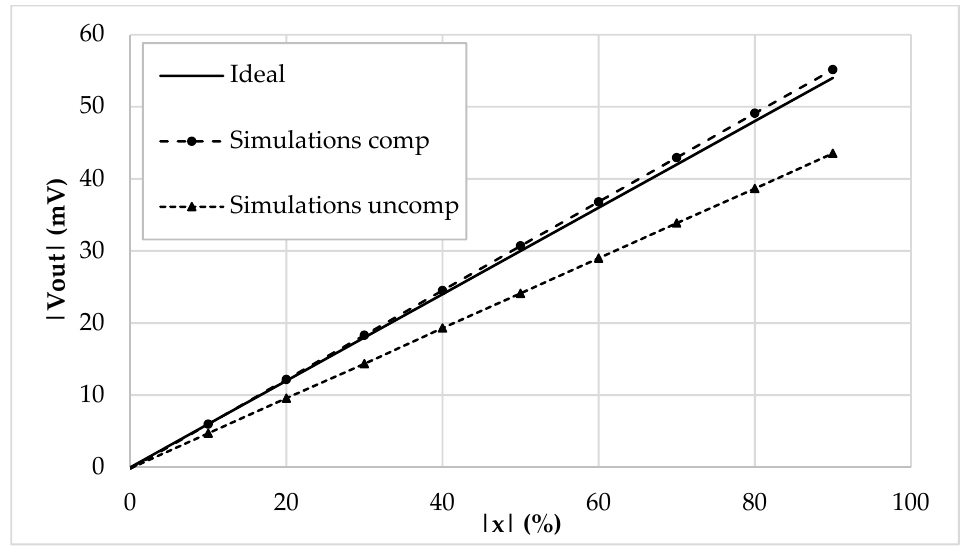
Figure 6. DC characteristic ( |V out | vs |x| ) of the integrated interface.